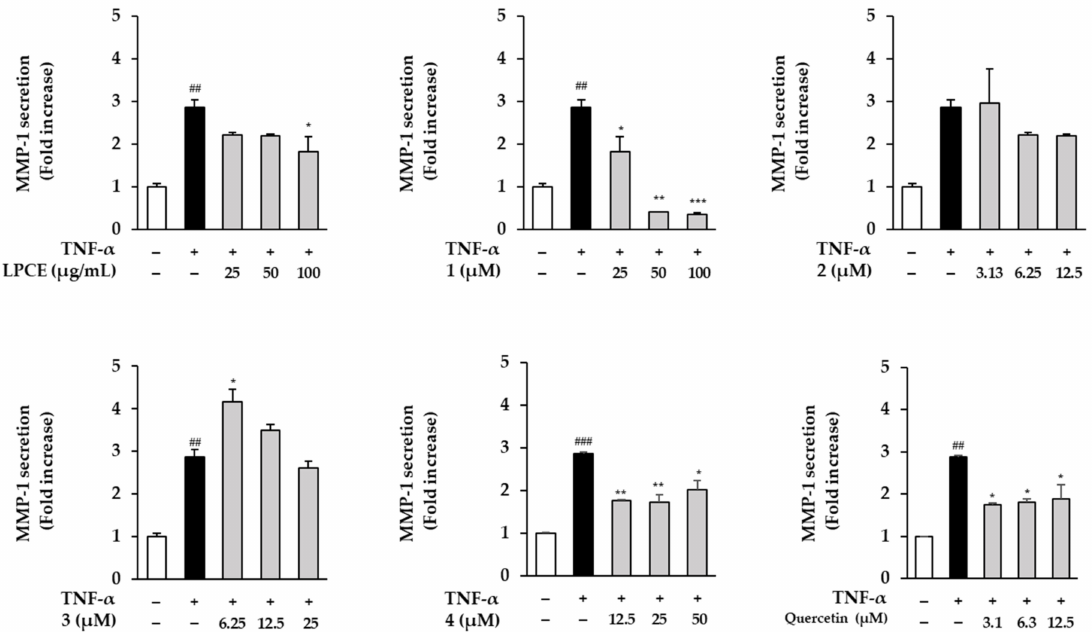
Figure 5. Effect of LPCE and compounds 1 – 4 from P. chinensis on MMP-1 protein expression in TNF- α -stimulated HDFs. The HDF cells were plated at a concentration of 1 × 10 4 cells/well in a black 96-well plate and incubated for 24 h. The previous media were exchanged with fresh media without FBS for 24 h for cell cycle arrest. After that, the extract and isolates were treated with the indicated concentration for 1 h, and continuously treated with 20 ng/mL of TNF- α for 24 h. The MMP-1 secretion levels were measured using an ELISA kit. The data are presented as mean ± SEM ( n = 2). ### p < 0.001 and ## p < 0.01 compared with the untreated group; *** p < 0.001, ** p < 0.01, and * p < 0.05 compared with the TNF- α -treated group. Quercetin was used as a positive